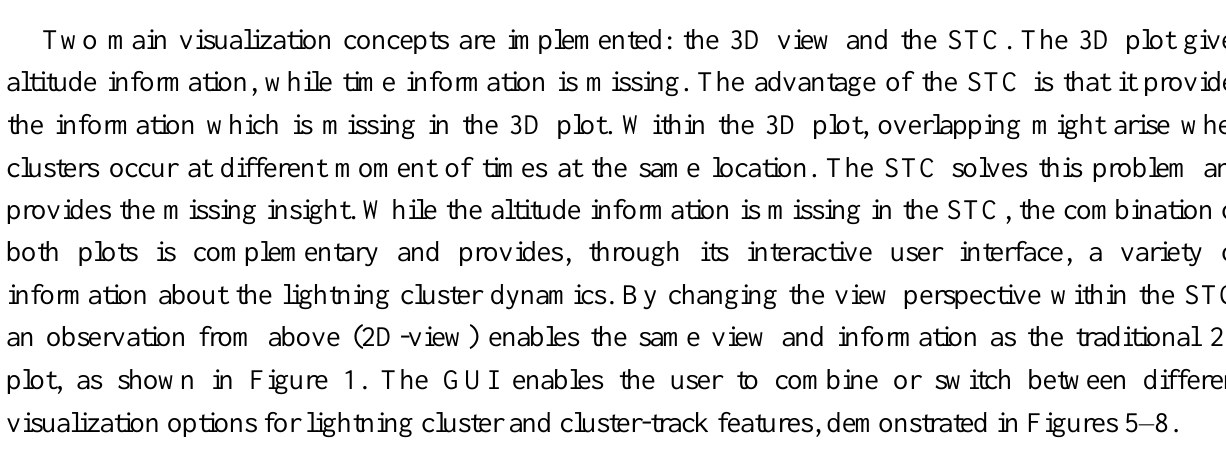
Figure 5. Lightning GUI for explorative analysis of past and nowcasted data.